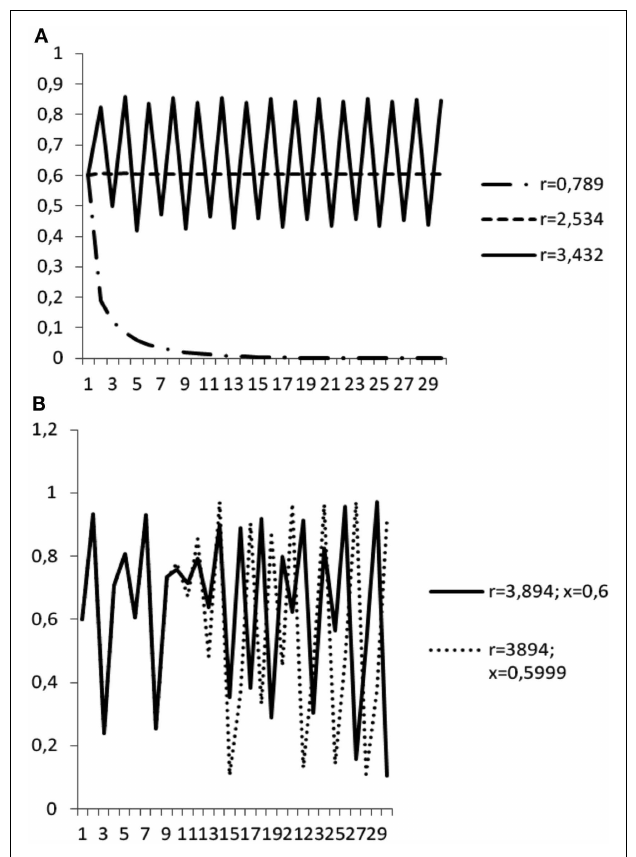
FIGURE 2 |The bifurcation route to chaos. (A) The dynamics of the system in a function of the control parameter ( r ). A bifurcation emerges when r > 3.45 (approximately). (B) The butterfly effect: the two systems are regulated by the same equation, have the same control parameter ( r = 3.894 – beyond the threshold for chaotic dynamics: r > 3.45) and very similar-but not identical-starting points ( x = 0.6; x =